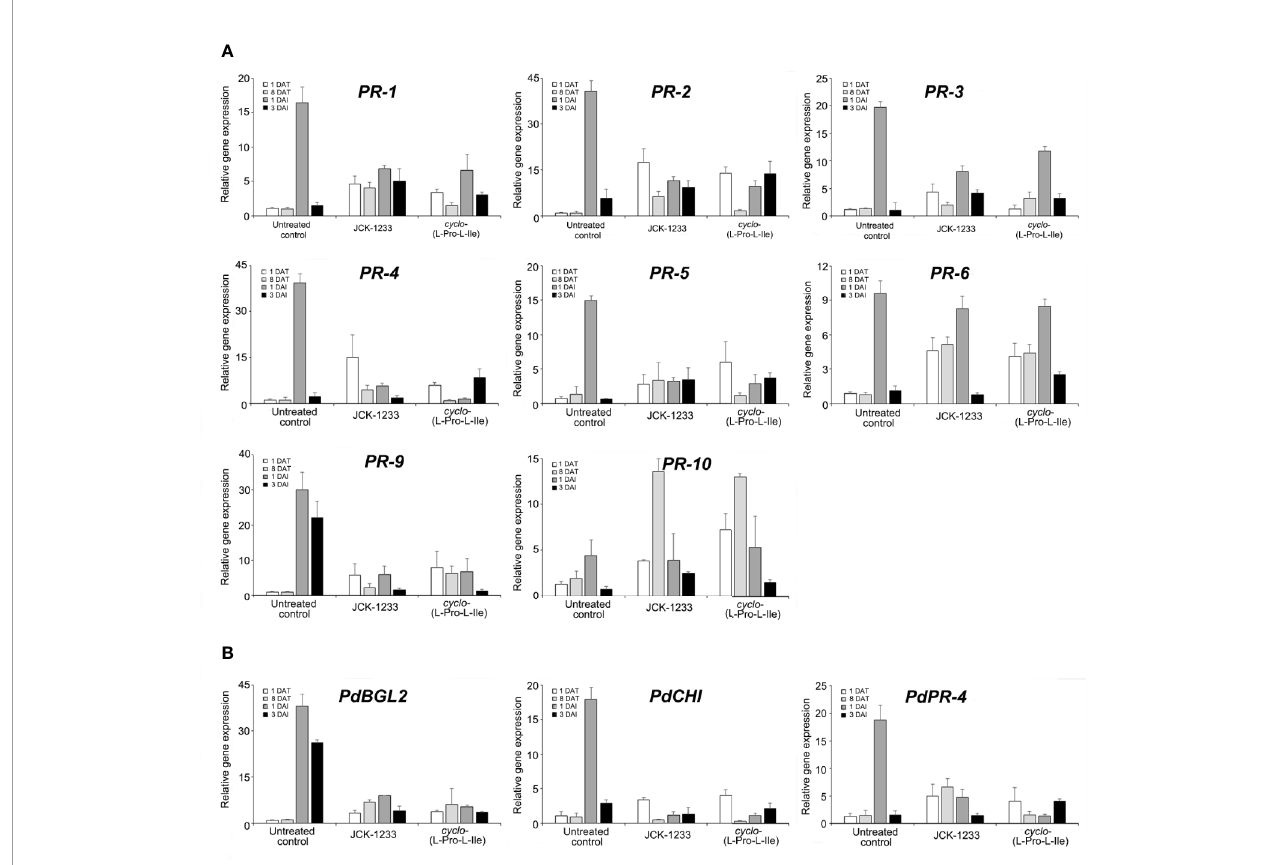
FIGURE 5 | Transcript levels of defense related genes in pine seedlings treated with Bacillus thuringiensis JCK-1233 and the bacterial active compound cyclo -(L- Pro-L-Ile). The expression of pathogenesis-related (PR) genes ampli fi ed with primers oriented from black pine trees ( Pinus thunbergii ) (A) and red pine trees ( Pinus densi fl ora ) (B) . Data was presented as the mean and standard error bars of three biological